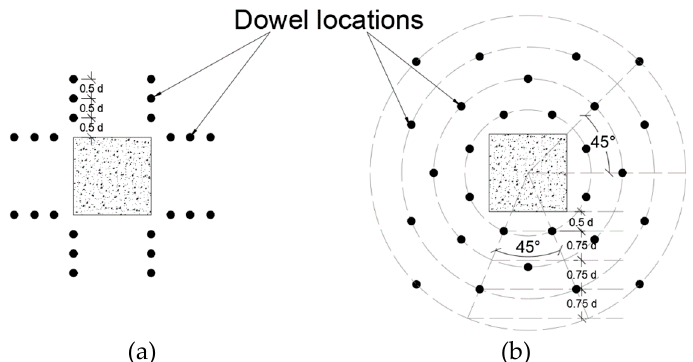
Figure 8. ( a ) Orthogonal “O” pattern of CFRP vertical shear reinforcement and ( b ) Circular “C” pattern of CFRP vertical reinforcement [34].